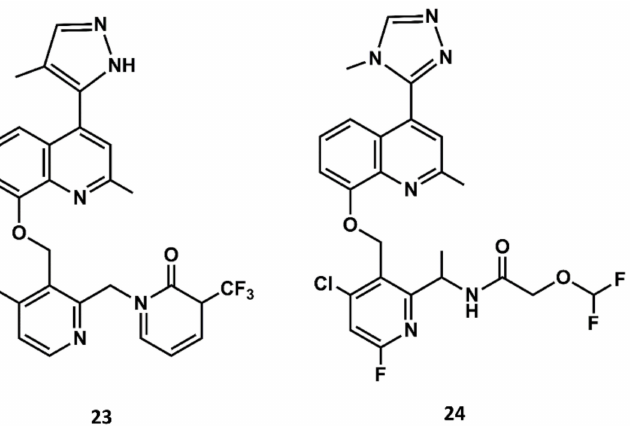
Figure 11. Chemical structures of diverse small molecule B2 antagonists: JSM10292 ( 23 ) and Com- pound 3 ( 24